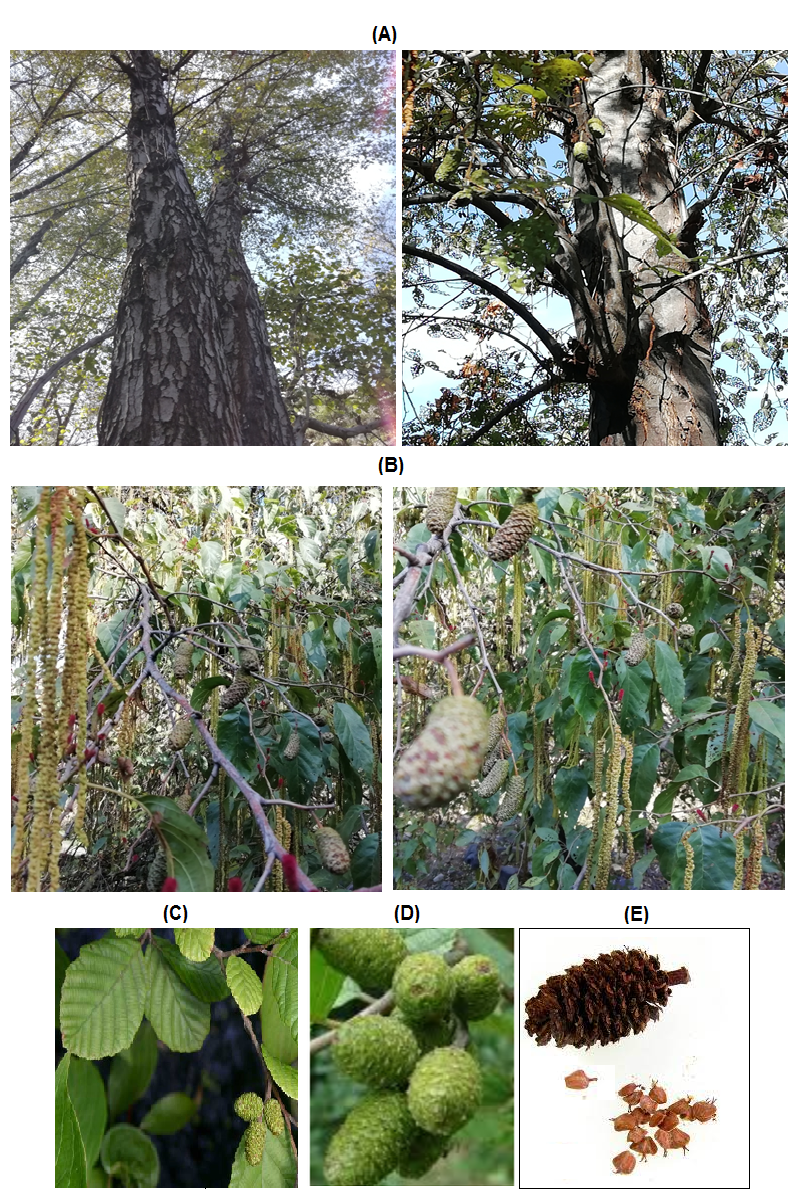
Figure 1. Alnus nitida (Spach) Endl. plant and its various parts. ( A ) Woody tree with dark red bark, ( B ) A. nitida tree bearing catkins and cones, ( C ) A. nitida leaves, ( D ) A. nitida cones, and ( E ) mature cone with seeds.